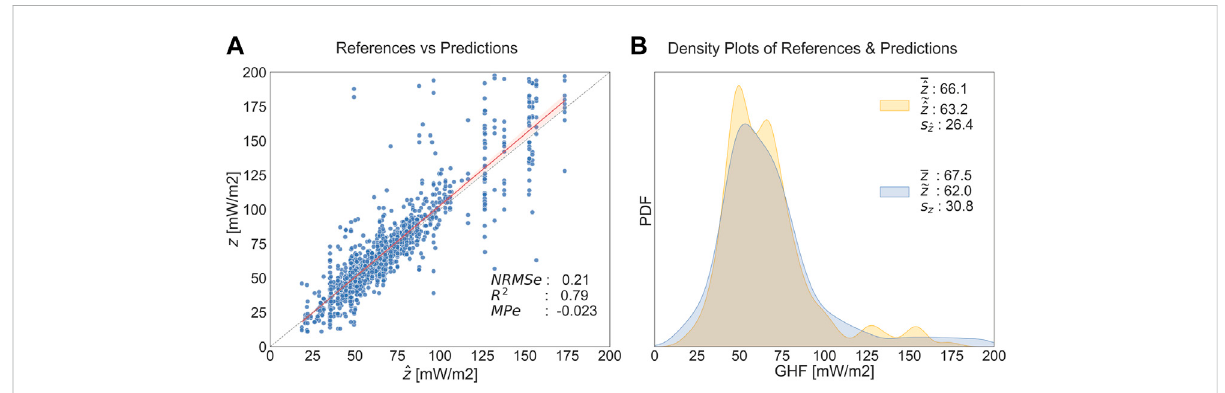
FIGURE 7 Performance indicators for the GHF model over Africa (AFQ) (A) Scatter plot of reference vs. predicted values together with coef fi cient of determination R 2 , NRMSe and Mean Percentage error MPe ; (B) Probability density plot of reference and predicted values. Light orange refers to predicted GHF values denoted by ^ z , whereas light blue refers to measured GHF values denoted by z ; (cid:1) z = mean, ~ z = median, s = standard